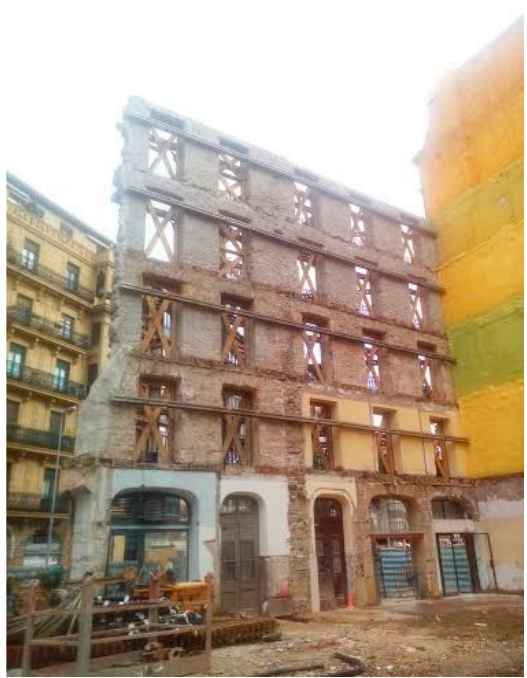
Figure 2. The elements of a typical load bearing stone wall, visible in detail during the building renovations of Easo street 1 and 2 cases.